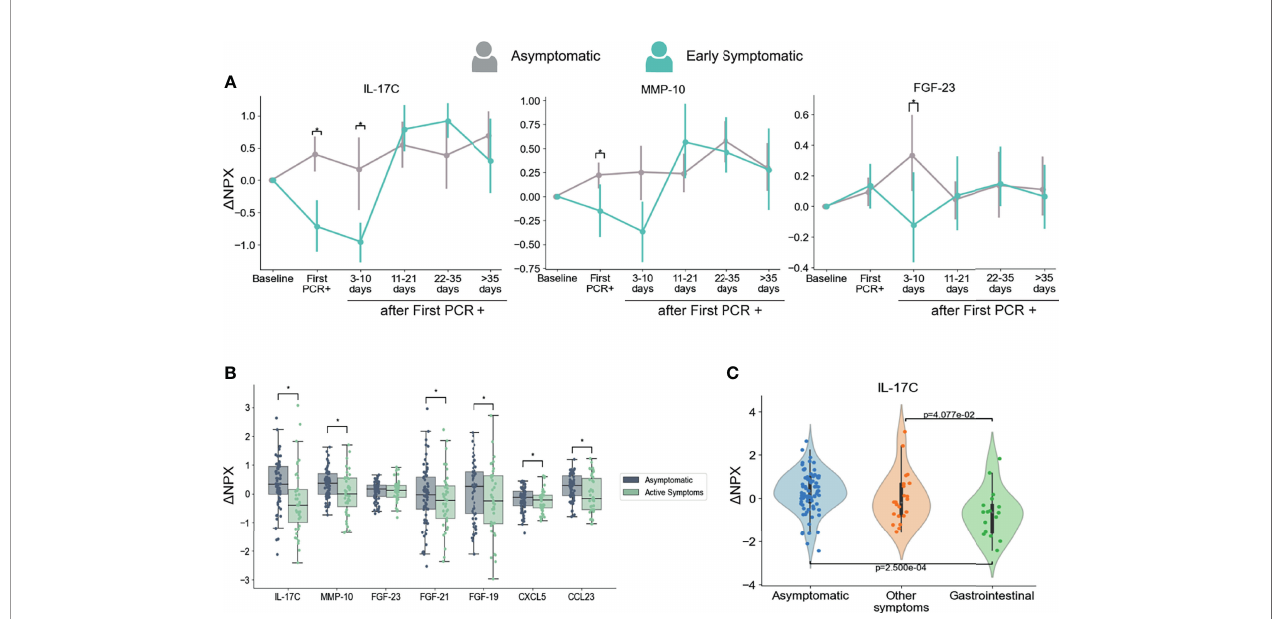
FIGURE 5 | Dynamics of serum markers that are higher in Asymptomatic participants as compared with Symptomatic participants. (A) Mediators that are signi fi cantly higher in Asymptomatic participants in comparison with Early Symptomatic participants. Mean and 95% CI are indicated. (B) Mediators with decreased levels in Symptomatic participants at the time points when they had symptoms (Active Symptoms) than in Asymptomatic participants at any time point (Asymptomatic). This analysis includes only samples collected at PCR+ timepoints and compares levels of PEA markers regardless time after fi rst PCR+. (C) IL-17C is differentially regulated in participants presenting with GI related symptoms (vomiting/nausea, diarrhea and/or abdominal pain) in comparison to participants that reported other symptoms, but none of them GI related, or to Asymptomatic participants. This analysis includes only samples collected at the time of fi rst PCR +. *p <